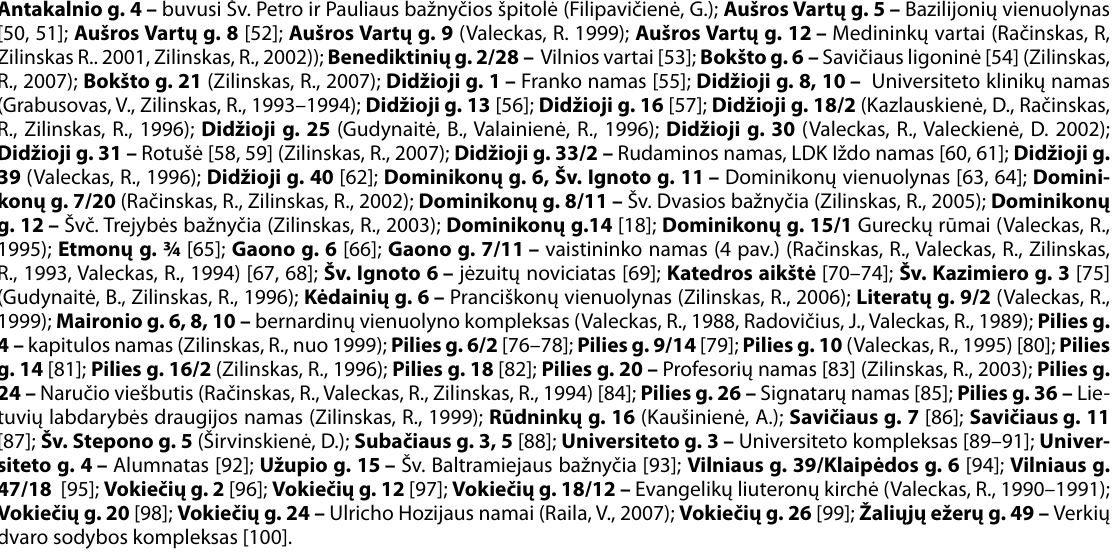
Table 2. buildings and complexes with signs of r­enaissance time reconstructions Antakalnio g. 4 – buvusi Šv. Petro ir Pauliaus bažnyčios špitolė (Filipavičienė, G.); Aušros Vartų g. 5 – bazilijonių vienuolynas [50, 51]; Aušros Vartų g. 8 [52]; Aušros Vartų g. 9 (Valeckas, r­. 1999); Aušros Vartų g. 12 – Medininkų vartai (r­ačinskas,